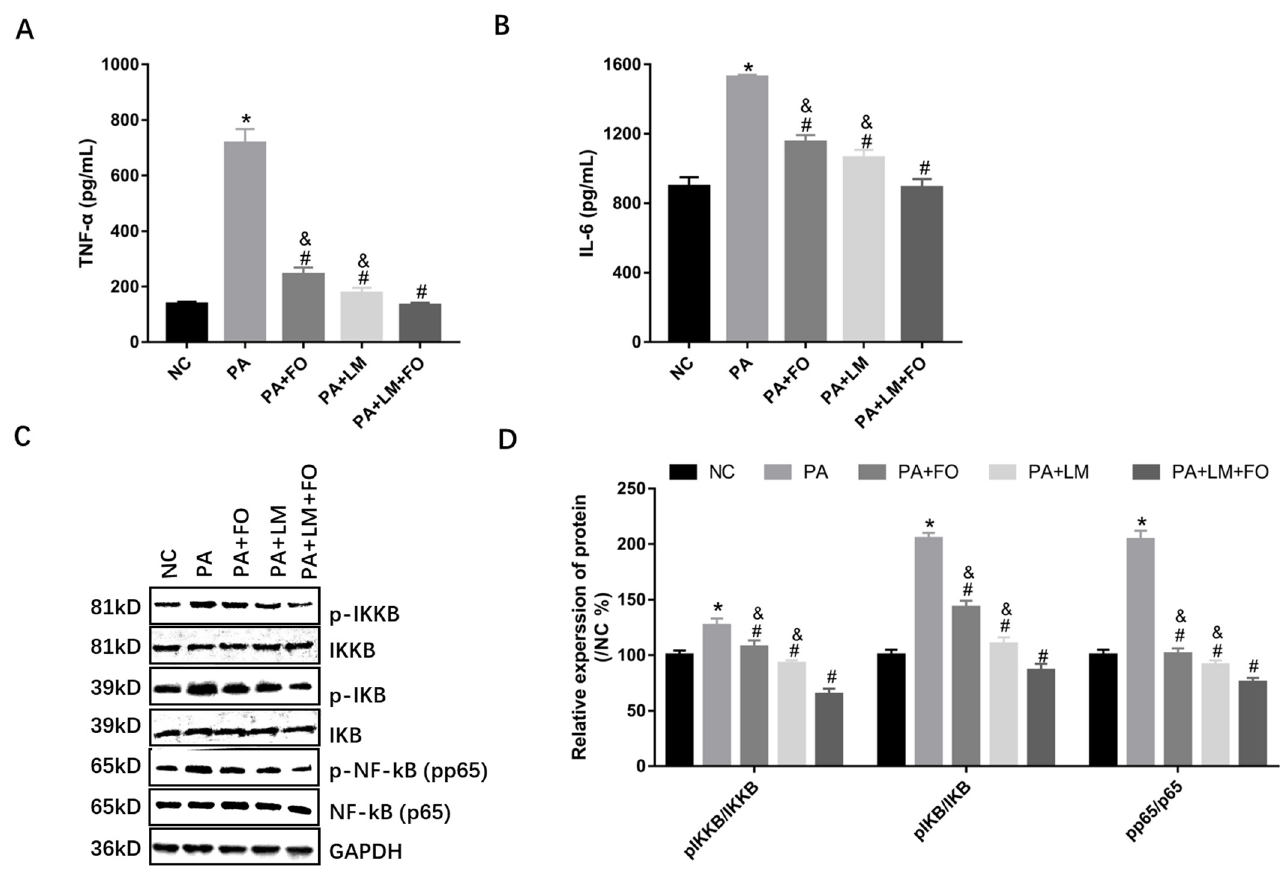
Figure 7. Effects of FO and LM on PA-induced inflammation in HepG2 cells. Levels of ( A ) TNF- α and ( B ) IL-6 in cell supernatants were detected. ( C ) Protein expression was detected by Western blot, including p -IKKB, IKKB, p -IKB, IKB, p -NF-kB (pp65), and NF-kB (p65). GAPDH was used as a reference protein. ( D ) Relative expression of p -IKKB/IKKB, p -IKB/IKB, and p -NF-kB (pp65)/NF-kB (p65) were calculated by ImageJ. Data are presented as means ± SD ( n = 3). * p < 0.05 vs. NC; # p < 0.05 vs. PA; & p < 0.05 vs. LM + FO.